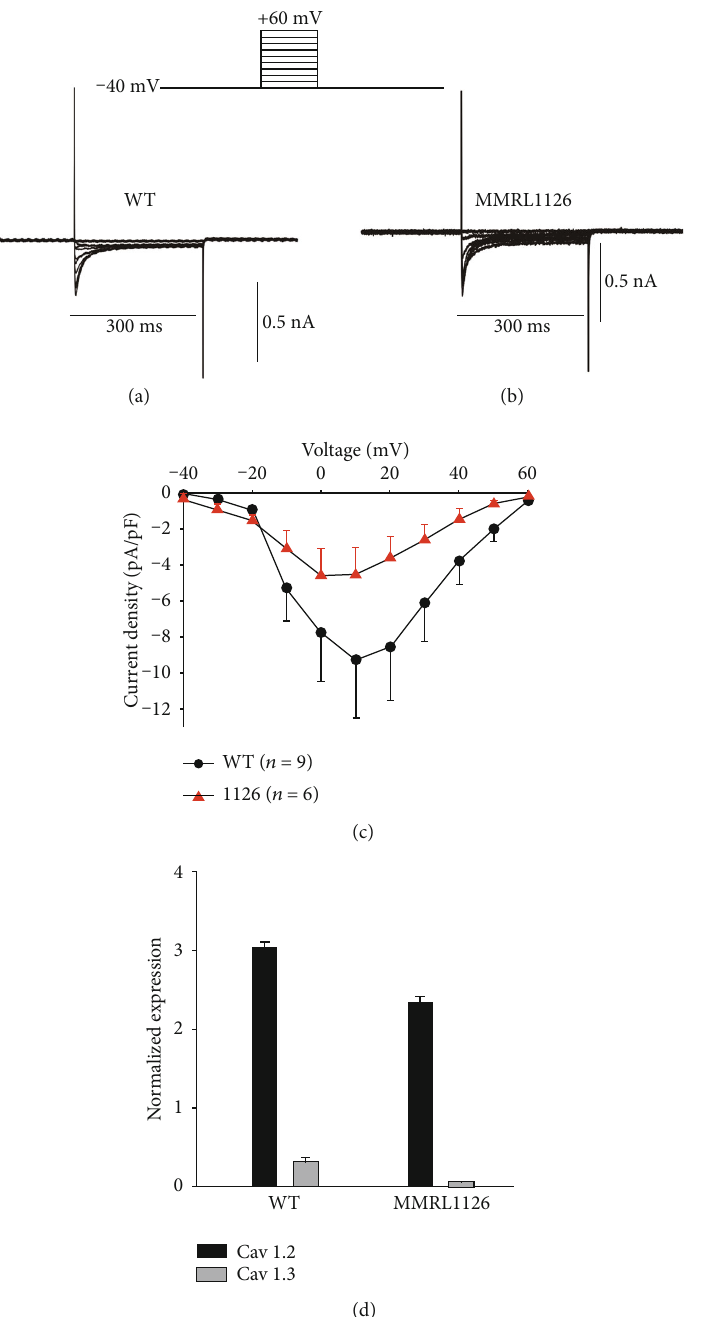
Figure 9: Representative traces showing I recorded from (a) WT and (b) MMRL1126. Ca 2+ currents were recorded during a 300ms step Ca depolarization from -40 to +50 mV in 10 mV increments. (c) Current-voltage relationship for I and Cav1.3 message in